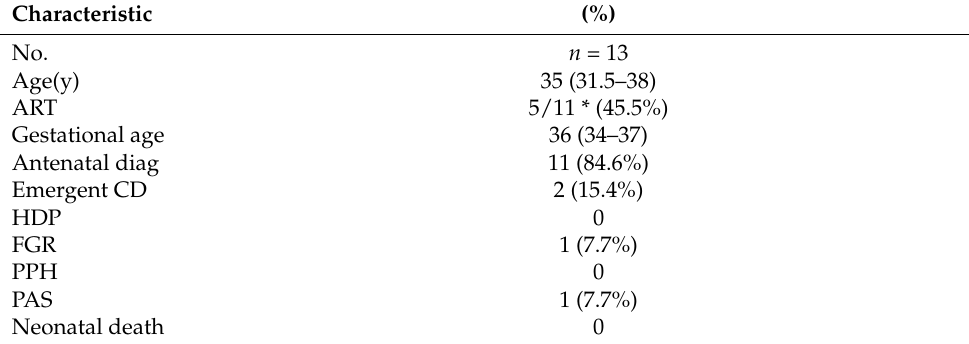
Table 3. Summary statistics for systematic literature